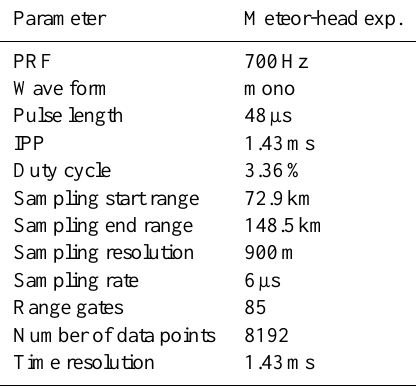
Table 1. Meteor-head echo experimental set-up during the ECOMA campaign in December 2010 (Latteck et al., 2012b); Pulse Repeti- tion Frequency (PRF), Inter-Pulse Period (IPP).